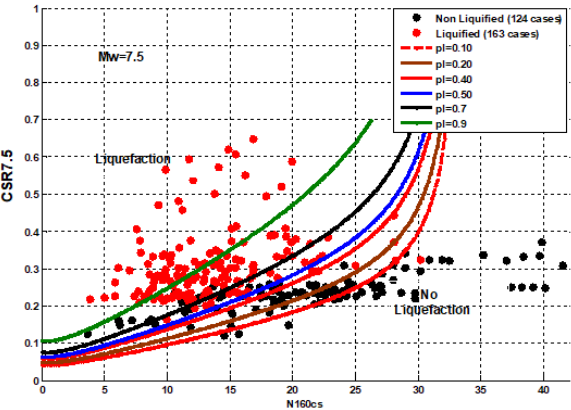
Figure 3: Relationship between P mapping function using the corrected version of the simplified procedure. PL = probability of liquefaction.